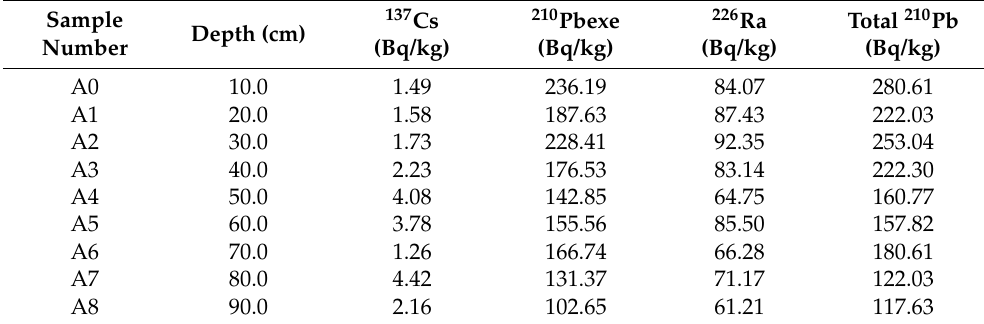
Table 1. The activities of 210 Pb, 226 Ra and 137 Cs in the 80 cm-long sediment core XX from the Xiangxi